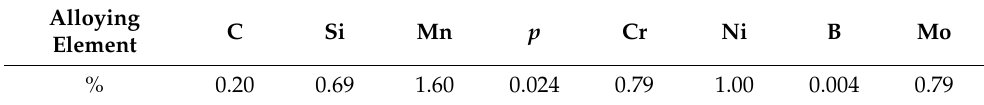
Table 1. Chemical composition H400